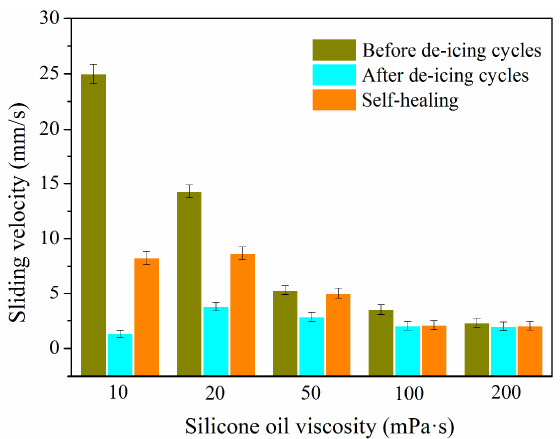
Figure 8. Sliding viscosities of the water droplets (30 μ L) on the SLIPS with an inclination angle of ~10° before and after 12 de-icing cycles, then held at room temperature for 3 h.